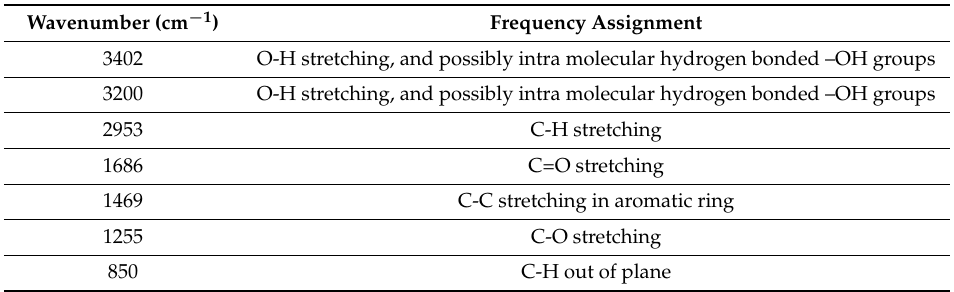
Table 2. The IR regions of the